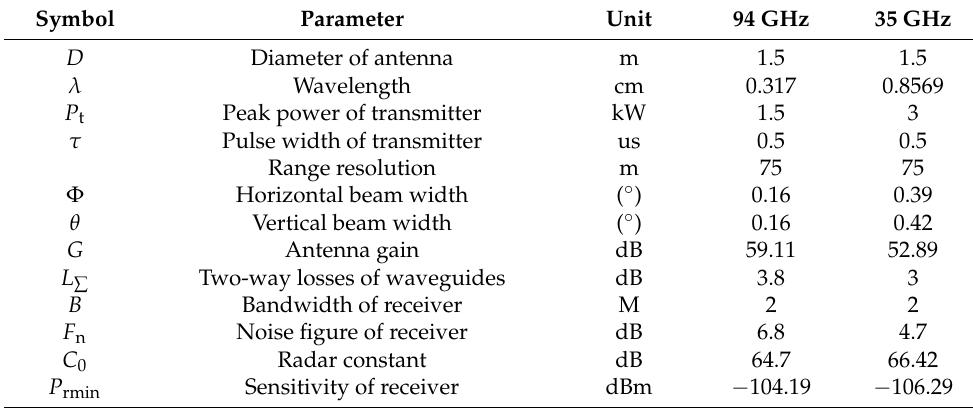
Figure 1. Dual-frequency cloud radar situated at Yangbajing Observatory. Table 1. Technical specifications of